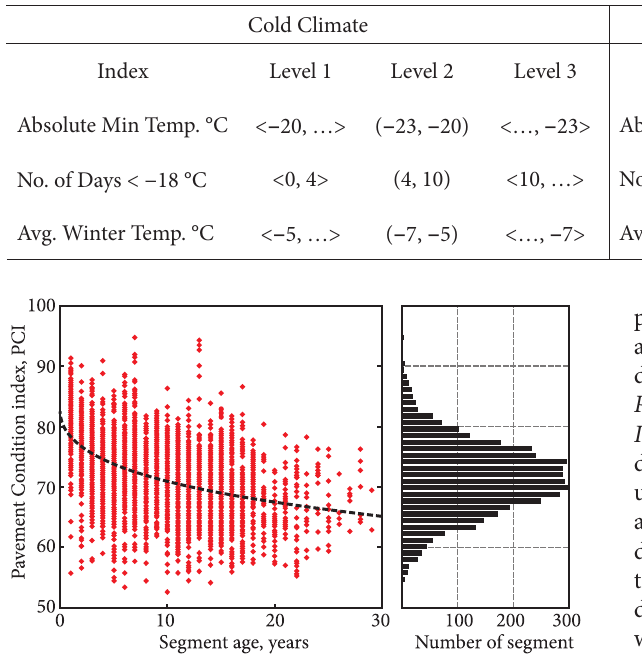
Fig. 5. Baseline pavement condition of network (as of 2010)